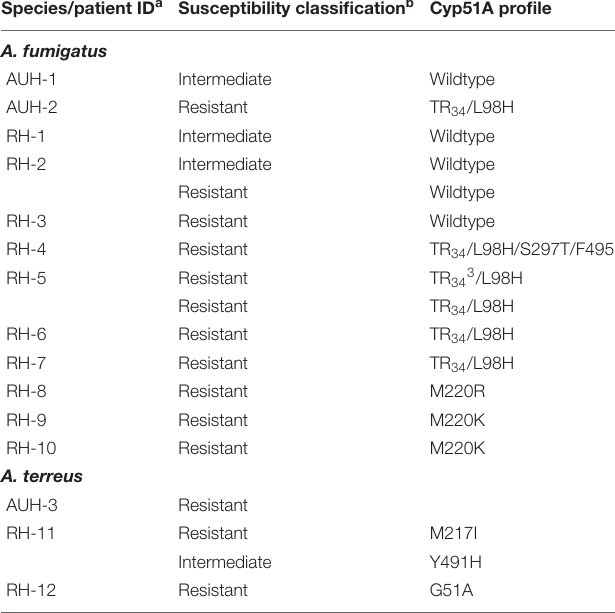
TABLE 2 | Cyp51A profile for 18 Aspergillus fumigatus and Aspergillus terreus isolates with decreased susceptibility from 15 CF patients at the two referral centers in